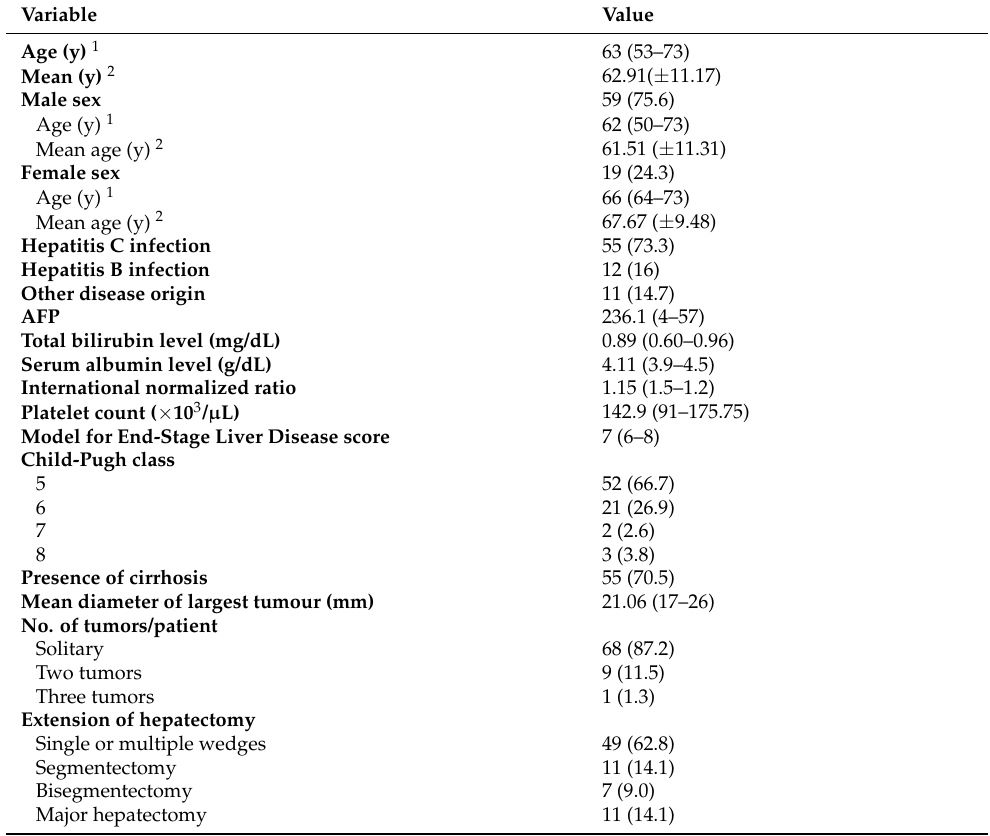
Table 1. Baseline Characteristics of the study